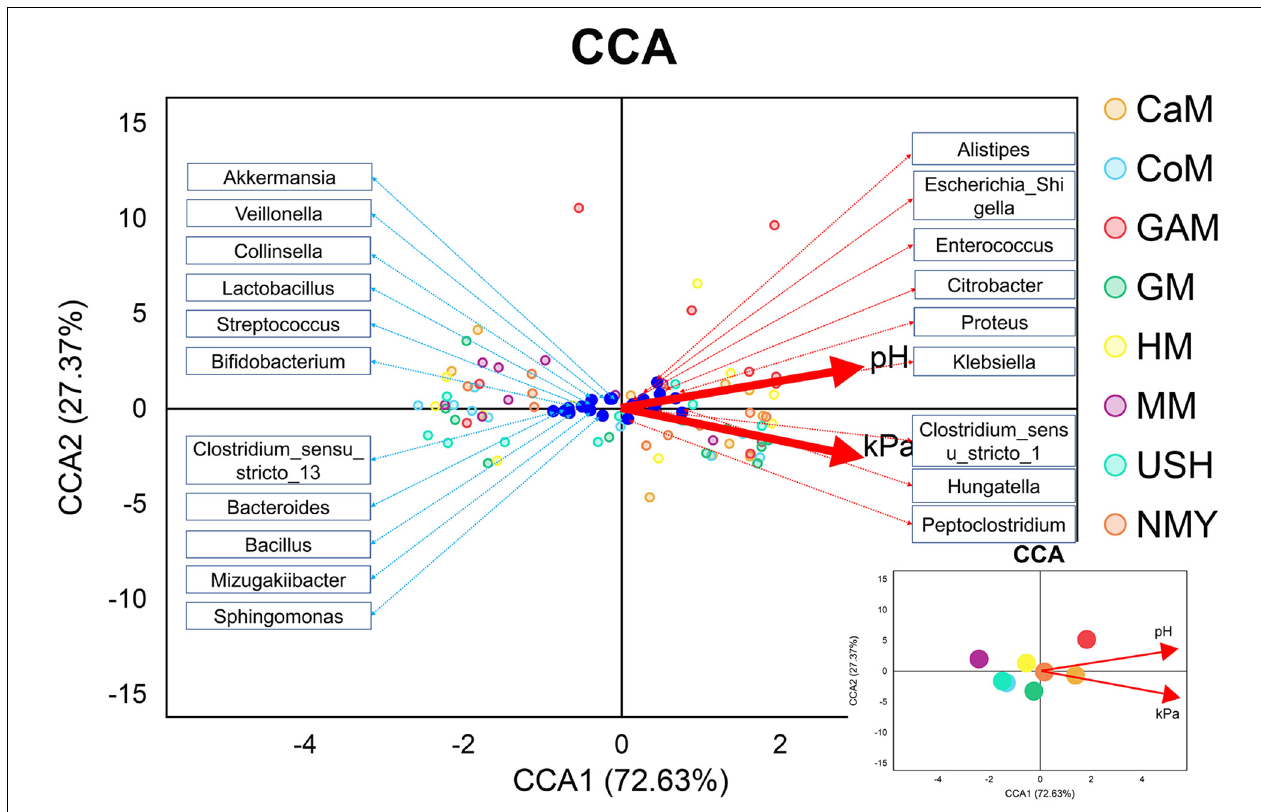
FIGURE 7 | CCA analyses. The blue dots represent the gut microbiota; the red lines represent the gas pressure and pH, and the small picture represents the correlation between gas pressure and pH with